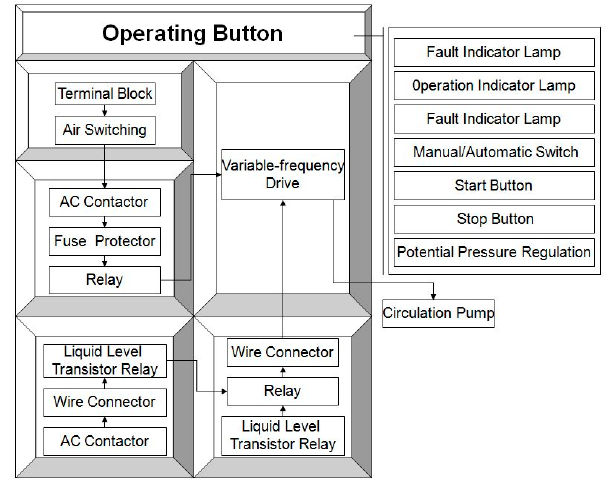
Figure 7. Design chart of the FCC employed in this study. AC Contactor, Alternating Current Contactor.